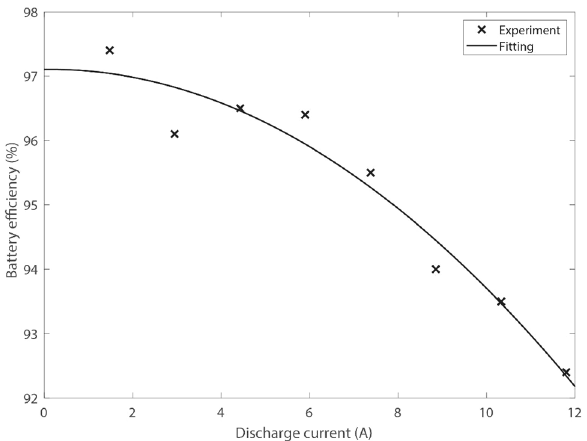
Fig. 9 Battery efficiency as a function of the discharge current